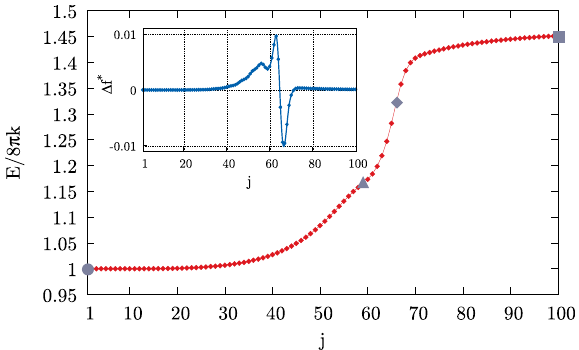
Fig. 7 MEP steepest stretch zoom. Re fi nement of the black line of Fig. 2b, obtained by evolving a new string made up of other 100 images, indexed with j (main plot, red line with small rhombuses). Image j = 100 corresponds to i = 14 of the original MEP, while j = 1 lies somewhere between images i = 10 and i = 11. The gray symbols identify the four con fi gurations of Fig. 6b: equilibrium of the two bilayers (circle); merging of the proximal interface region (triangle); merging of the distal interface region (rhombus); saddle point con fi guration (square). The blue line with small dots in the inset shows the difference between the forces on the ϕ < 0 and ϕ > 0 regions of a single interface as described in the main text. Note that the triangle and rhombus states identi fi ed on the main plot correspond to the two minima of the